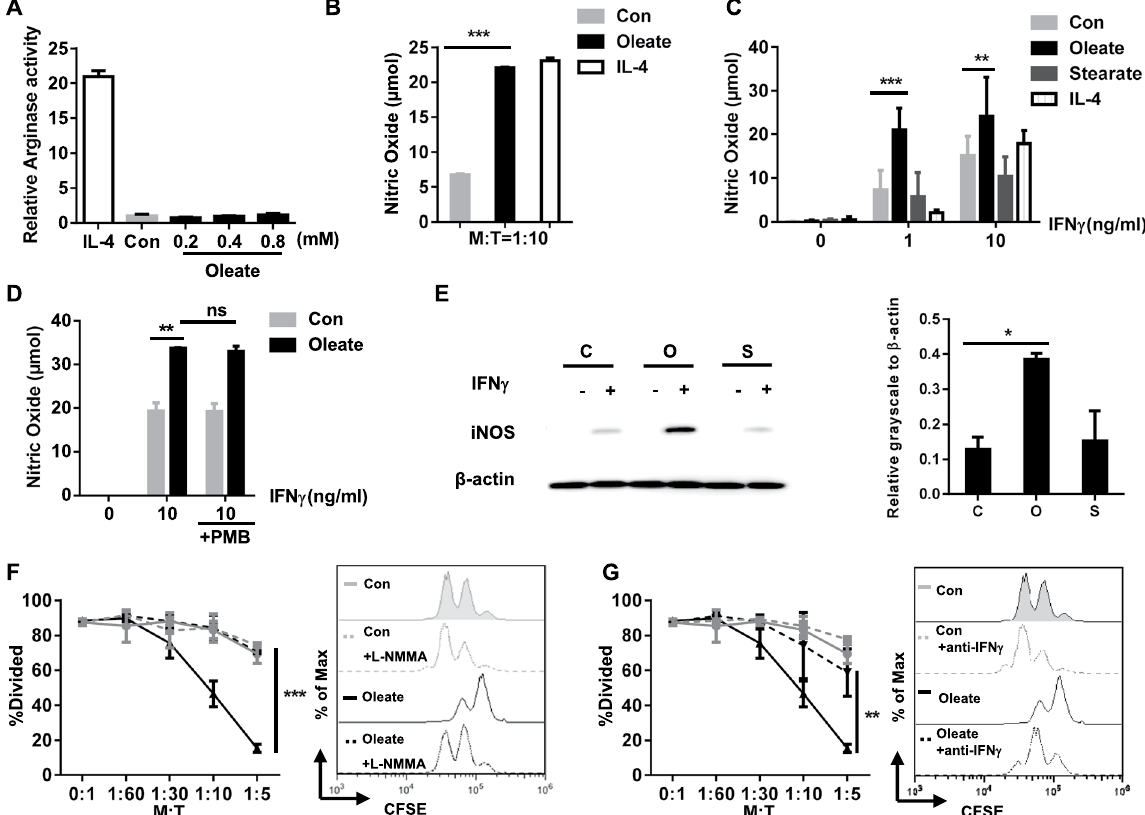
Figure 3. The sodium oleate-induced regulatory phenotype of MSC-2 cells depends on NO production but not arginase activity. MSC 2 cells were cultured in the presence of either IL-4 (100 ng/ml), BSA (Con) or sodium oleate (0.2 mM). After 24 h arginase activity was determined ( A ). MSC-2 cells were co-cultured with purified CD4 + T cells for 72 h in the presence of either BSA, sodium oleate (0.2 mM) or IL-4 (100 ng/ml) and NO was measured via Griess reagents in the supernatant ( B ). MSC-2 cells were stimulated with the indicated concentrations of IFN γ for 24 h in the presence of either BSA (Con), sodium oleate (0.2 mM), sodium stearate (0.2 mM), IL-4 (100 ng/ml) and IFN γ as indicated. NO was measured via Griess reagents in the supernatant ( C ). MSC-2 cells were treated with BSA (Con), sodium oleate (0.2 mM) in the presence or absence of IFN γ (10 ng/ml) and polymyxin B (10 µ g/ml) as indicated ( D ). MSC-2 cells were pretreated overnight with BSA ( C ), sodium oleate (O) or sodium stearate (S) and subsequently stimulated for 8 h with IFN γ (1 ng/ml). Cell lysates were analyzed by Western blot analysis for iNOS as well as beta-actin expression. Quantitative evaluation in relation to β -actin expression was performed. Shown is the mean ± SD of n = 2 experiments ( E ). MSC-2 cells were co- cultured with CD4 + T cells in the ratios indicated and in the presence or absence of BSA (Con), sodium oleate (0.2 mM) and the iNOS inhibitor L-NMMA (2.5 mM) ( F ) or anti-IFN γ (10 µ g/ml) ( G ). Cell proliferation was evaluated by CFSE staining after 72 h. Shown is the mean ± SD from two to four independent experiments. * p < 0.05; ** p < 0.01; *** p <